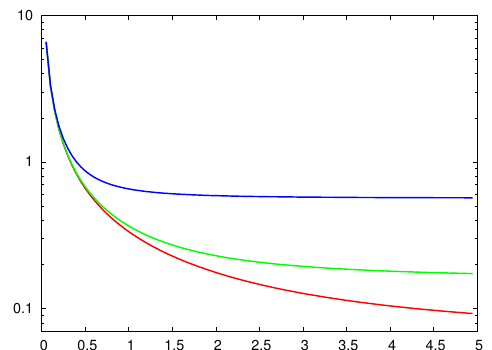
Fig. 13. Evolution of the ratio output noise/input noise depending on the value of input noise. Red curve: decorrelated noise ( β =0); green curve: correlated noise ( β =1); blue curve: strongly correlated noise ( β =2); a constant level of 1 is also drawn (in black) for reference. The estimated asymptotic values for the input/output ratios are 0.09, 0.17, and 0.57, respectively. The crossovers (passings by 1) occur for input noise levels of 0.33, 0.33, and 0.40, respectively.